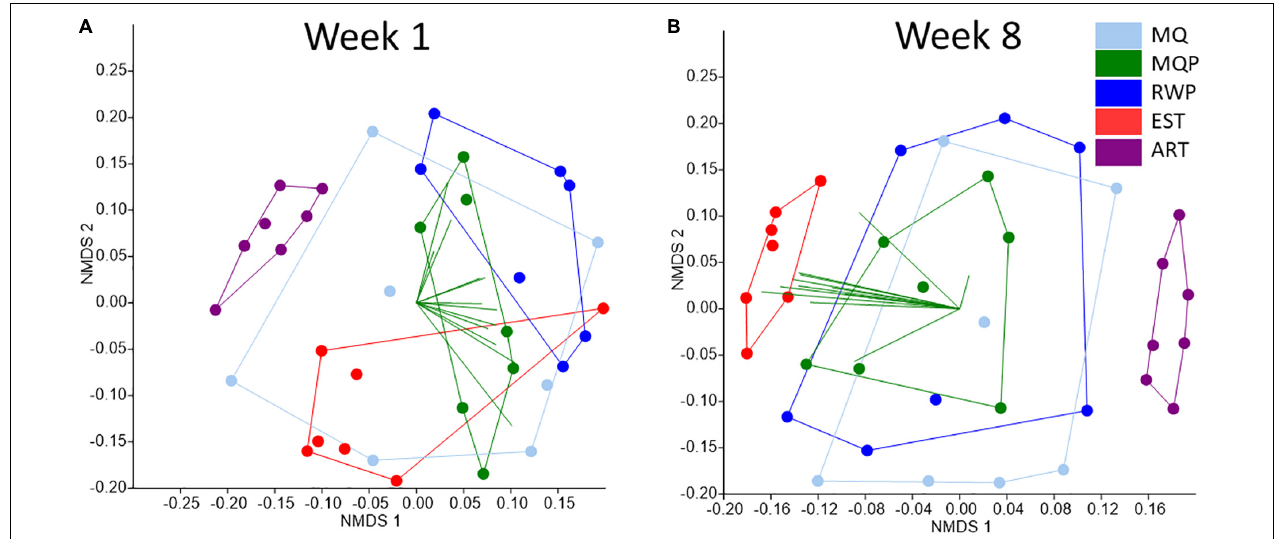
FIGURE 8 | NMDS plots of predicted functional analysis of bacterial composition in 7 replicate pitchers in each of 5 treatments comparing week 1 (A) and week 8 (B) , using the Euclidean distance calculator. Both the NMDS data and the 12 vector overlays originate from PICRUSt-predicted bacterial metabolic functions. The 12 vectors included are nucleotides, kinase, Nitrogen, Signaling, Xenobiotics, Amino Acids, Arginine/Proline biosynthesis, Carbohydrate degradation, Bacterial Carbon fixation, Photosynthesis, Phenylalanine Tyrosine Tryptophan biosynthesis (PAA_TYR_TRP), and cell cycle and